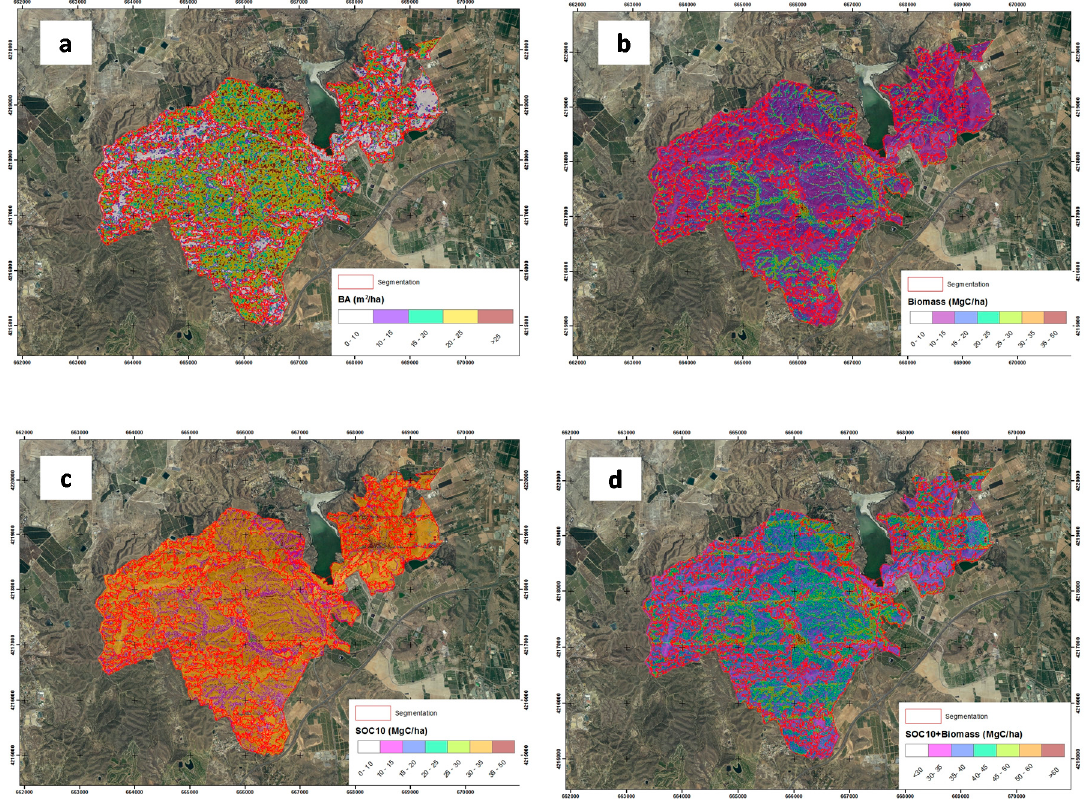
Figure 5. Maps obtained using semi-automatic forest stand delineation (Orpheo ToolBox software, OTB) and the basal area per hectare (G) at 0.5 pulses m − 2 density ALS data. ( a ) Multiresolution segmentation; ( b ) Mean-biomass stock (Mg ha − 1 ), ( c ) Soil organic carbon stock (SOC-S 10 0–10 cm soil layer); and ( d ) Biomass + SOC-S 10 C of Pinus halepensis plantations at Los Cuadros (Murcia, Spain). Note that the areas along the drainage system concentrate the highest biomass values.